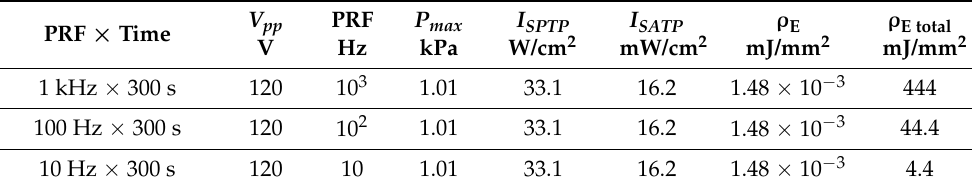
Table 2. Sonication parameters for the short pulse protocols (five cycles of high amplitude P and the same energy density ρ in all cases), with the same total time of sonication (300 s) and variable pulse repetition frequency (PRF; 1 kHz, 100 Hz, or 10 Hz), such that the total energy provided to the cells increases. PRF × Time